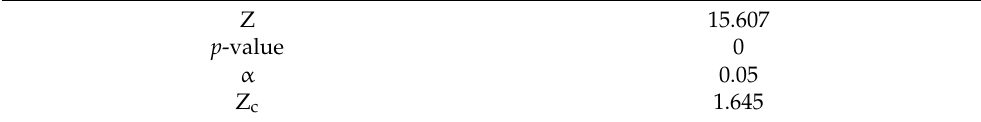
Table 18. Z-test